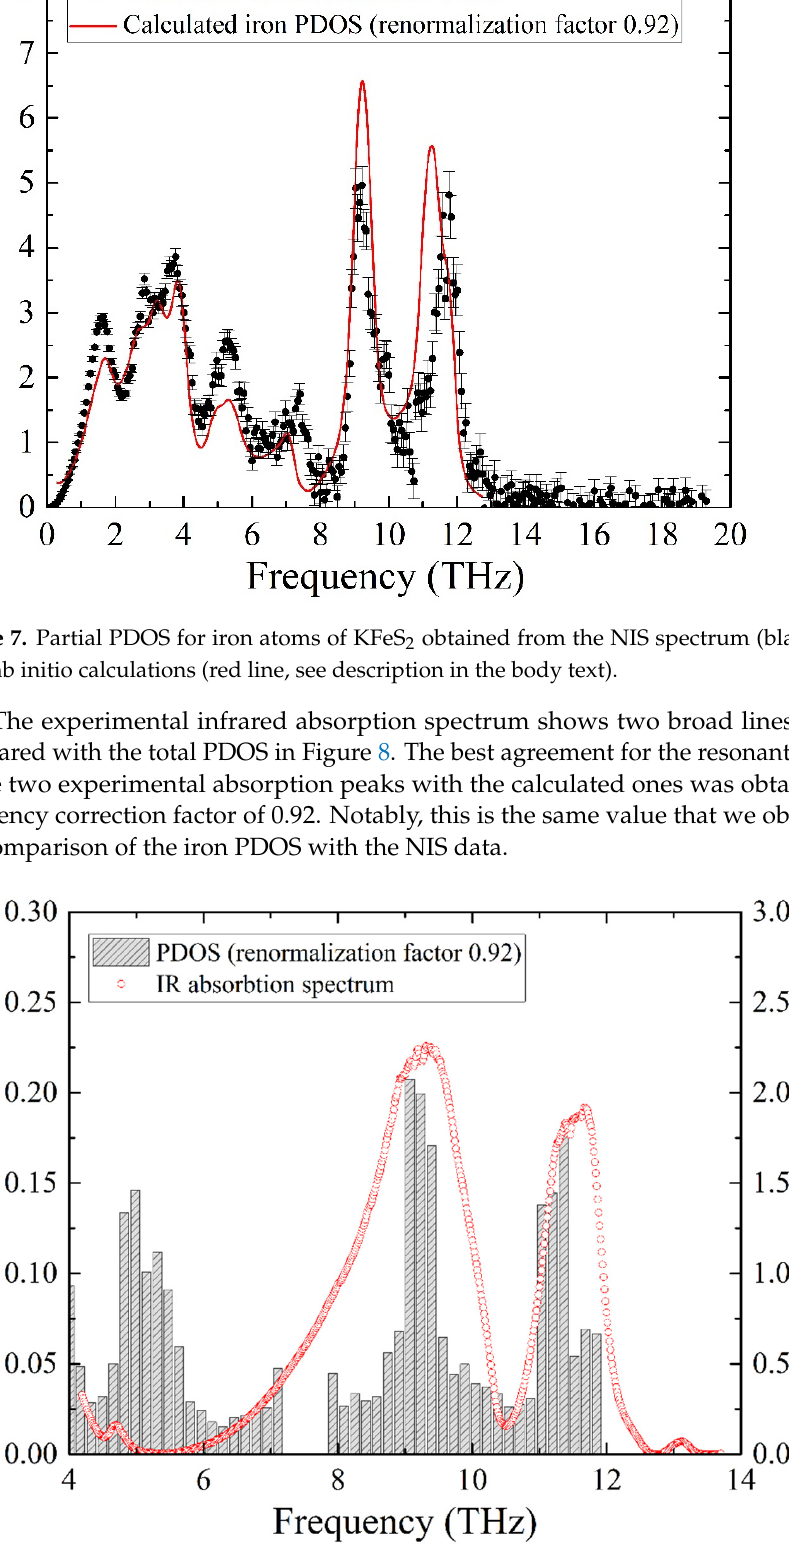
Figure 8. Infrared absorption spectrum of KFeS 2 compared with the calculated PDOS of KFeS 2 . The frequency scale of the PDOS is corrected to obtain the best coincidence of the peaks of PDOS maxima with the IR absorption maxima (shaded bar charts).